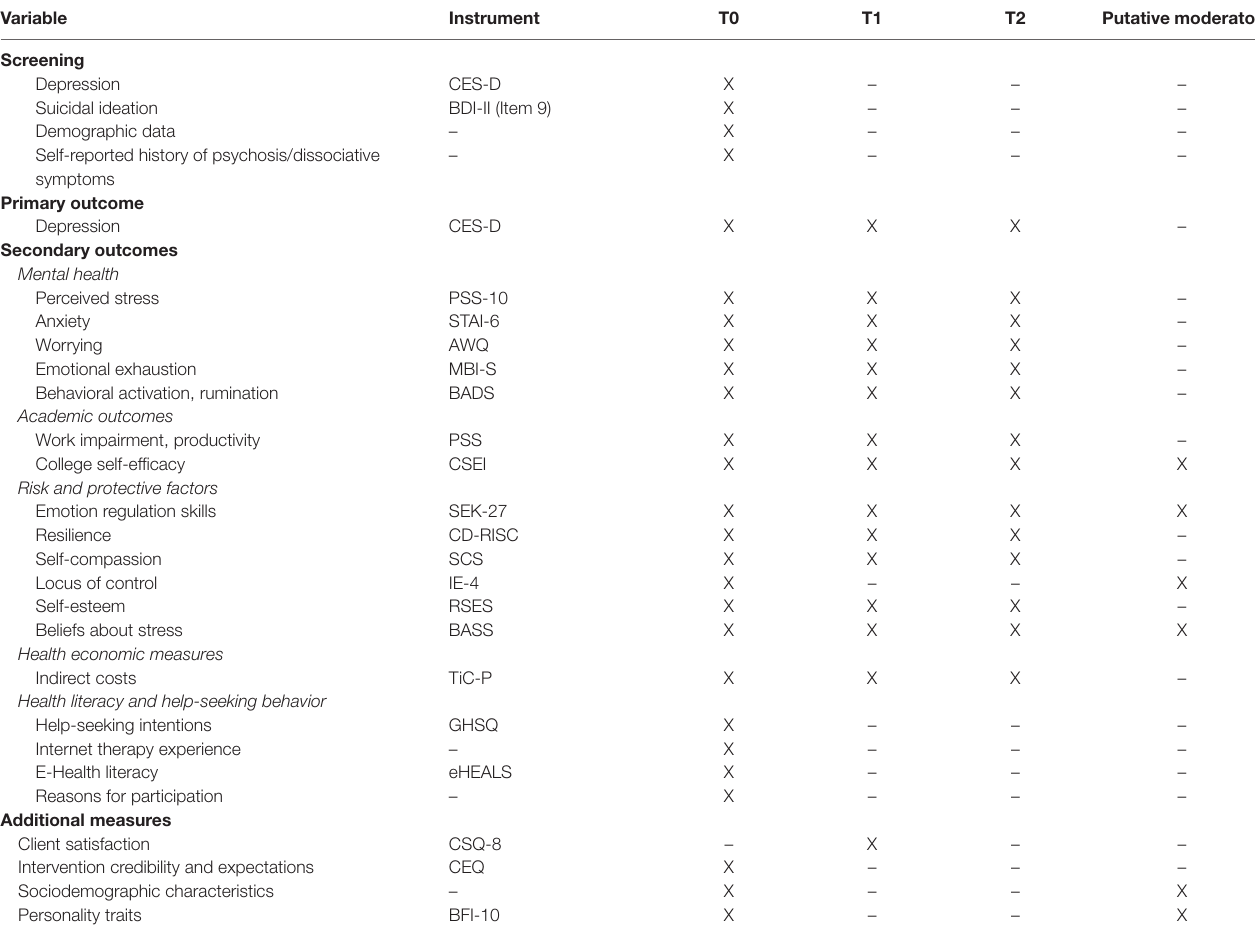
TABLE 3 | Overview of instruments and assessment points. Variable